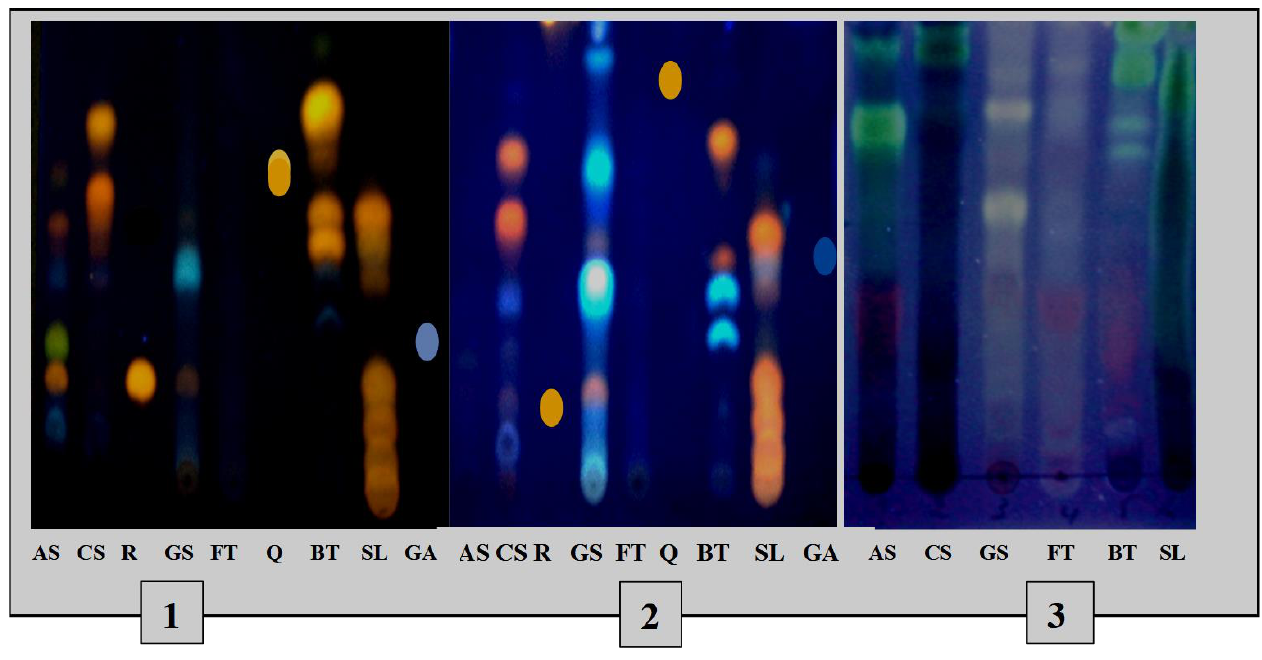
Table 3. Results of phytochemical screening of species.